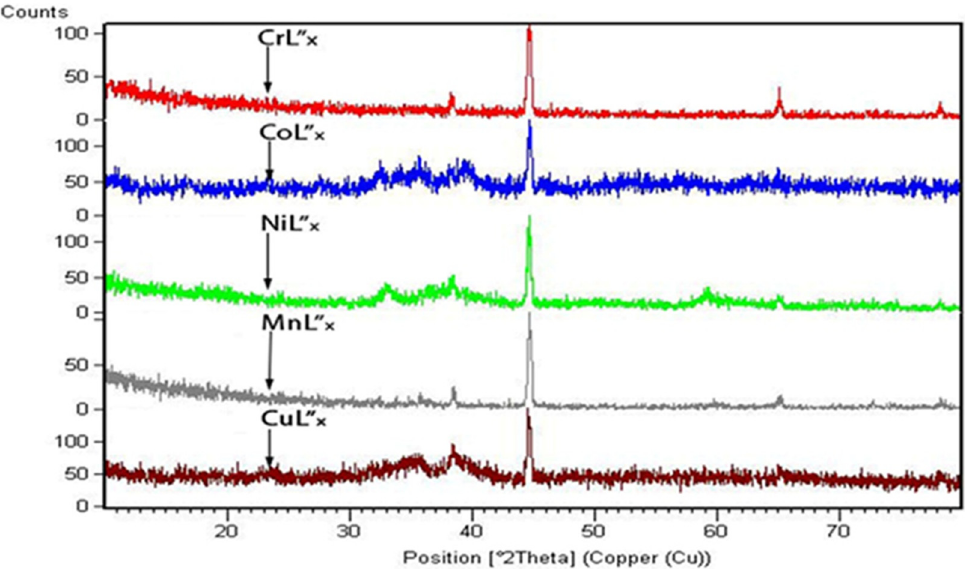
Figure 4. X-ray Diffraction Patterns of Compounds 4 – 8 . Table 5. Crystal lattice Data and Summary of Data Collection and Refinement for Compounds 4 – 8 . Table 4. Crystallographic data and observed refinement parameters for compounds 4 – 8